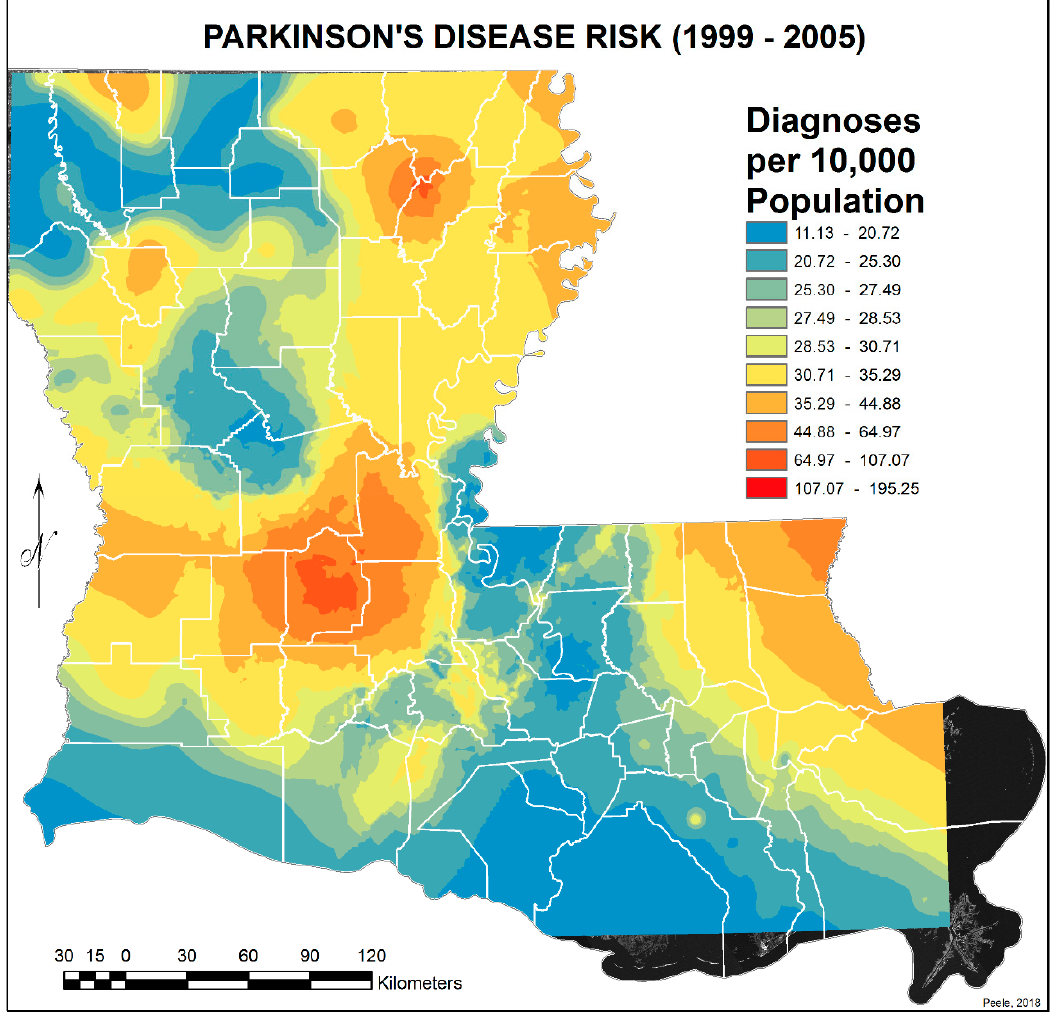
Figure 3. Empirical Bayesian Kriging interpolated predictive surface of Parkinson’s disease (PD) risk values derived from the ZIP code ‐ based Parkinson’s disease risk data shown in Figure 1 for 1999– 2005.